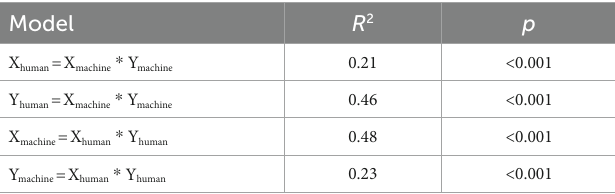
TABLE 1 Regressions predicting coordinates of embedding in one space from those in the other. Model